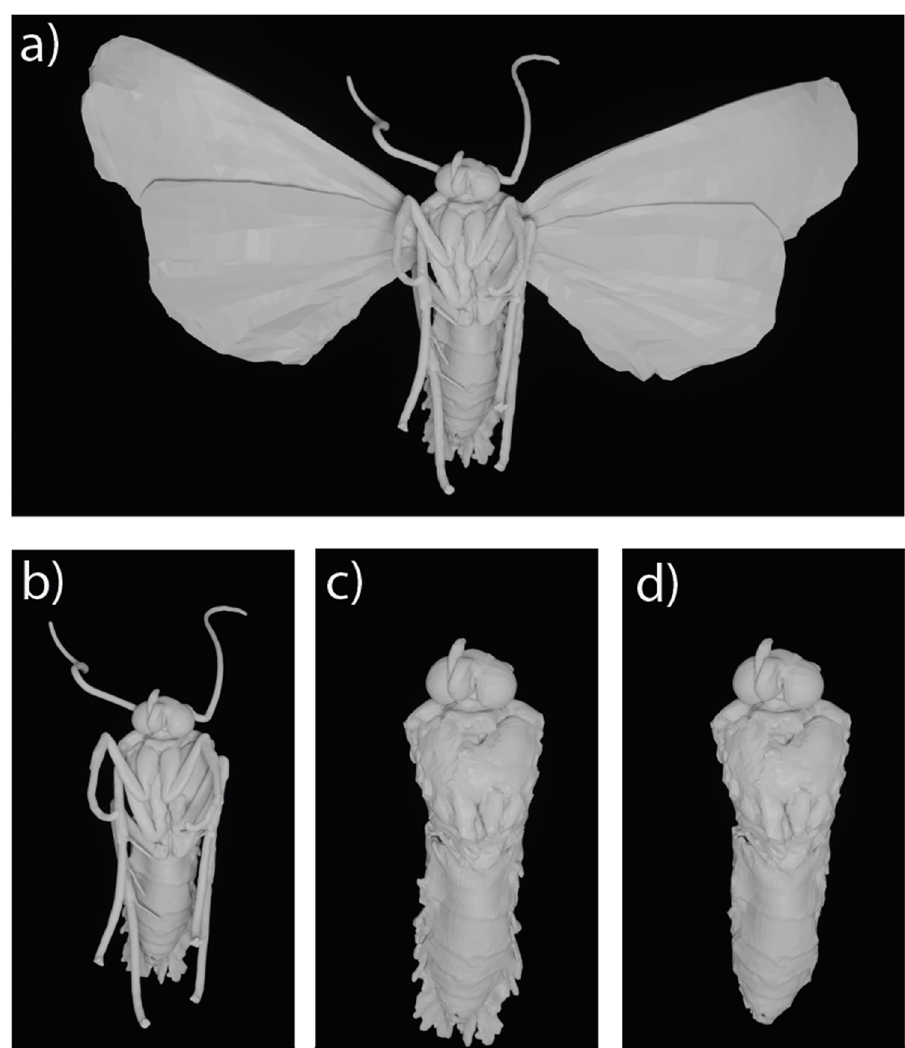
Figure 4. The ventral view of the 4 specimen morphologies examined in this study: ( a ) the Full model, depicts the complete morphology of the moth, while ( b ) the Wingless model excludes the wings, ( c ) the Body Only model further excludes the legs and antennae, and ( d ) depicts the Body Only model and further excludes the hair covering the thorax and the abdomen.